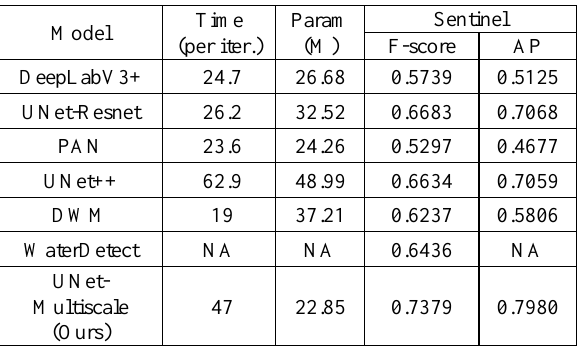
Table 2. Comparison of Water Contour Detection using our RGB dataset for Sentinel.